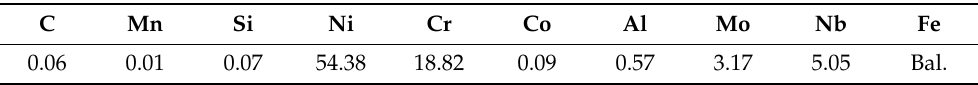
Table 1. Chemical analysis of Inconel 718 powder (weight